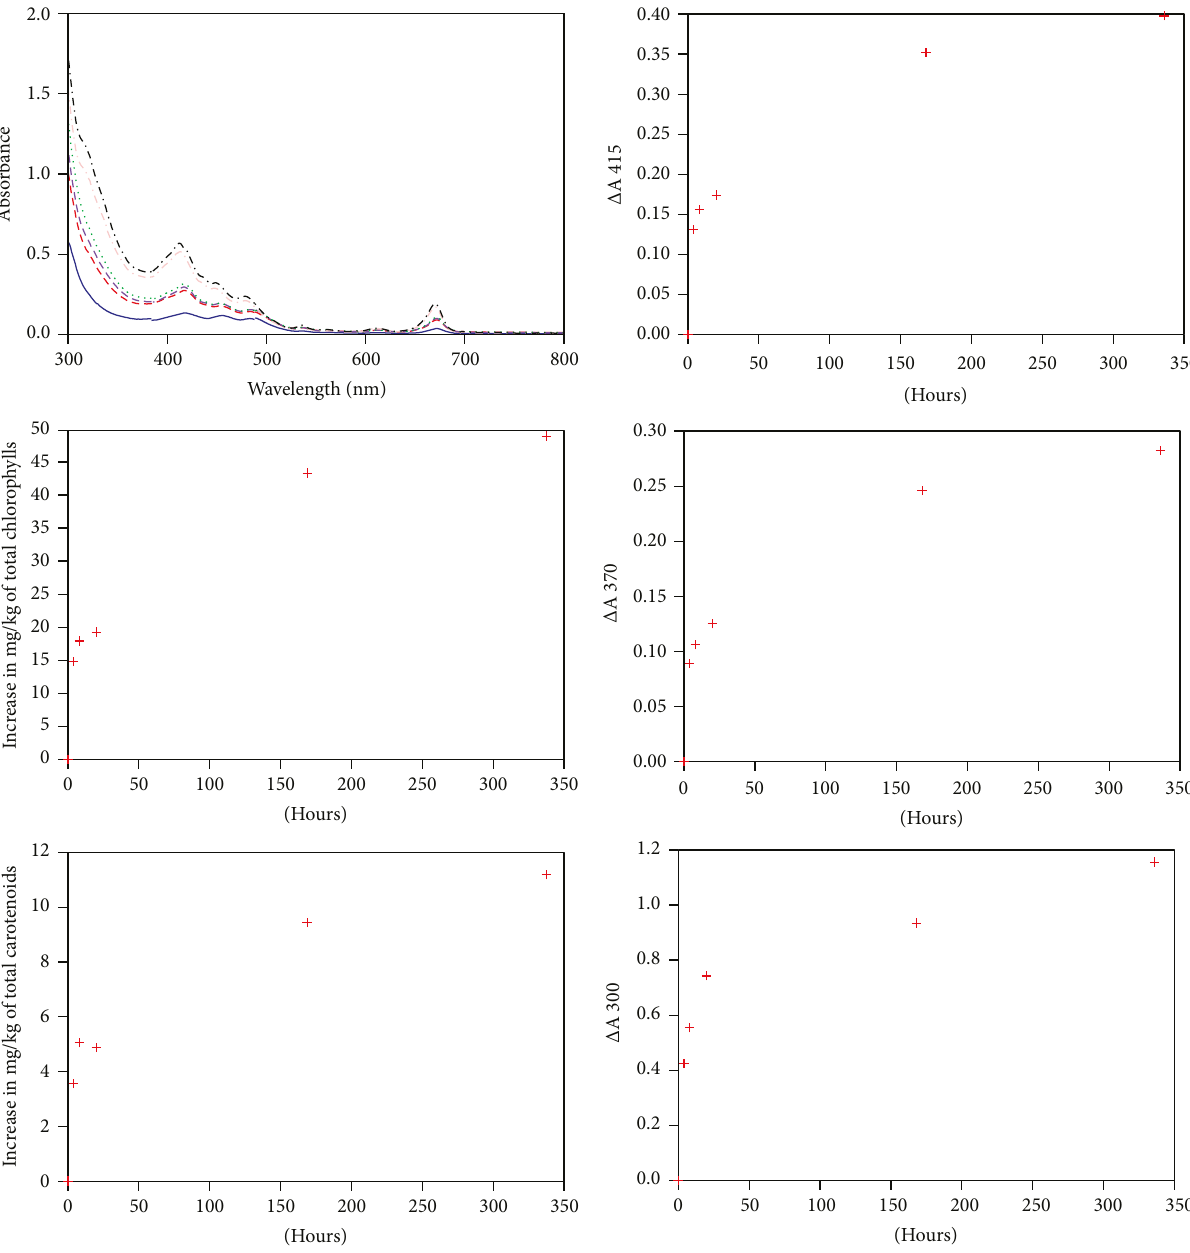
Figure 1: Rosemary conventional maceration, results of UV-Vis